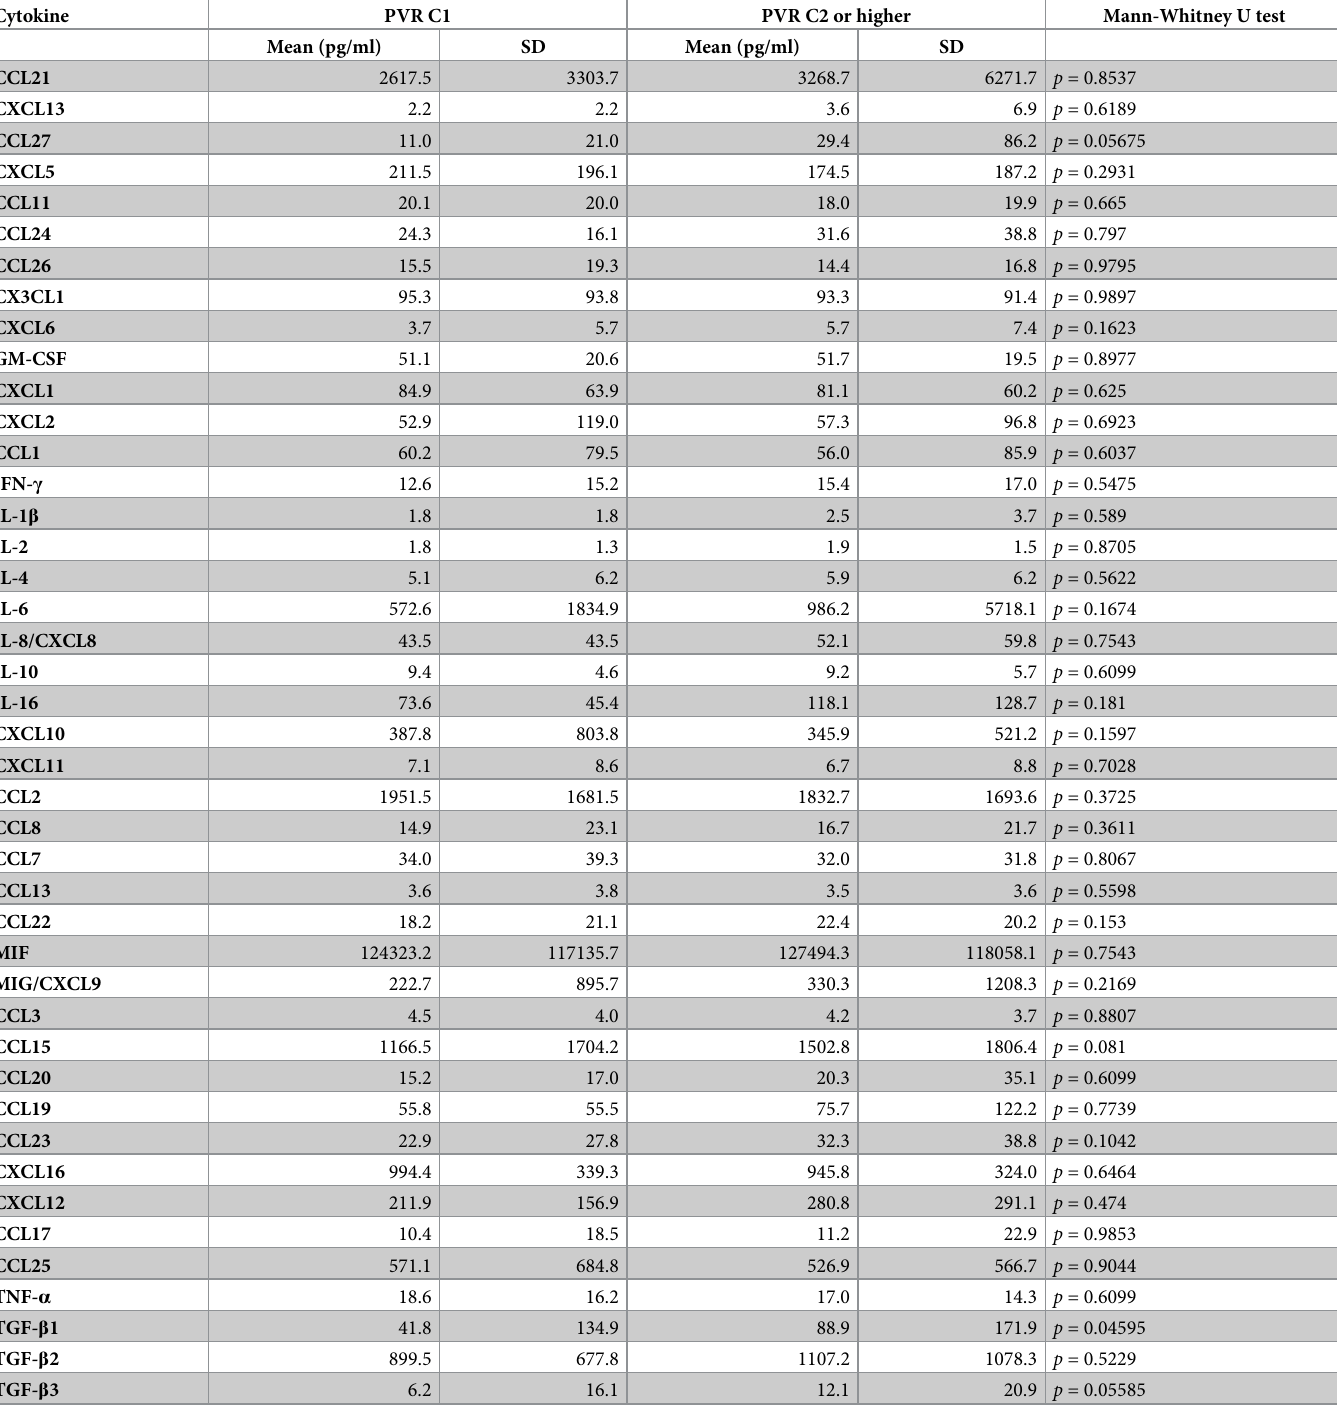
Table 6. Mean concentrations (pg/ml) and standard deviations (SD) of cytokines in the vitreous of eyes with primary retinal detachment with PVR grade C1, and in eyes with PVR grade C2 or higher.